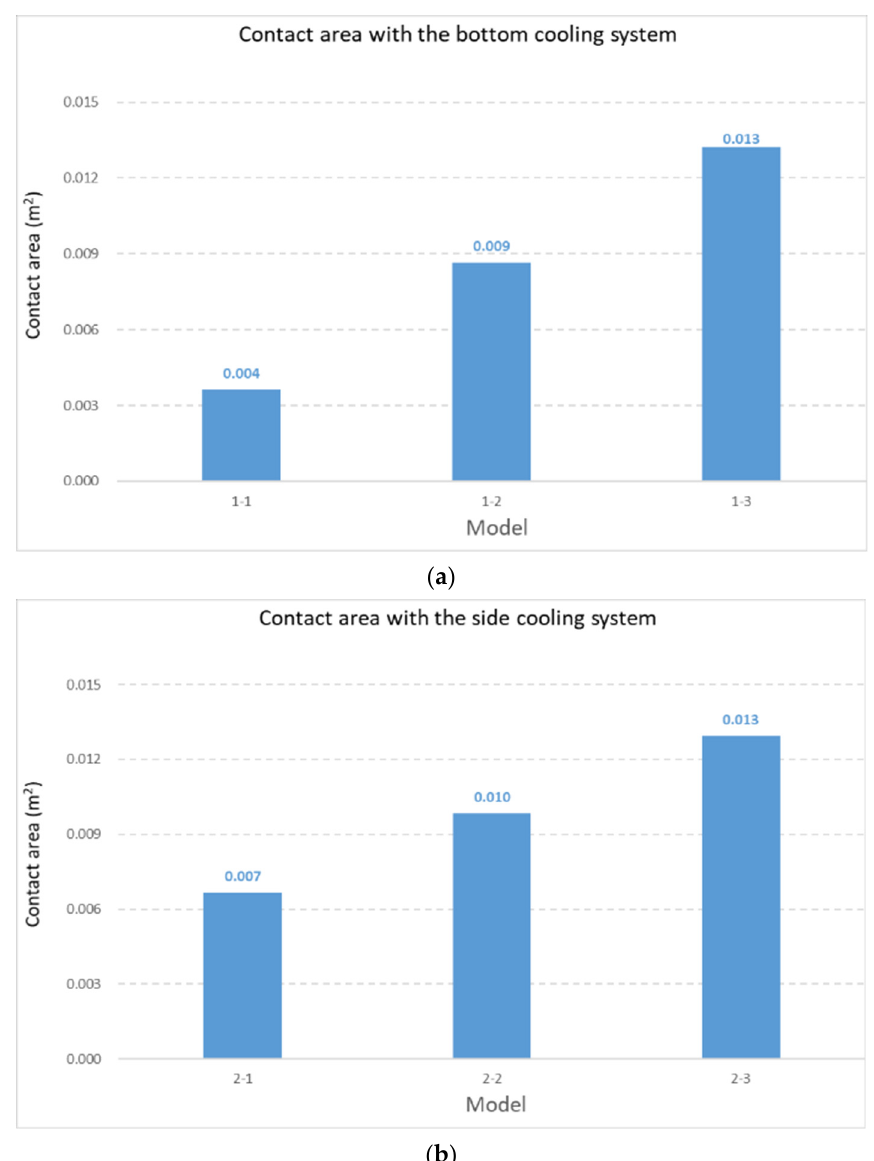
Figure 14. Contact area for the bottom ( a ) and side ( b ) cooling systems.